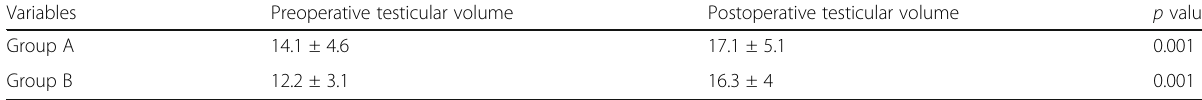
Table 3 Evaluation of testicular catch-up of the left side (pre-operative and after 24 months post-operatively)